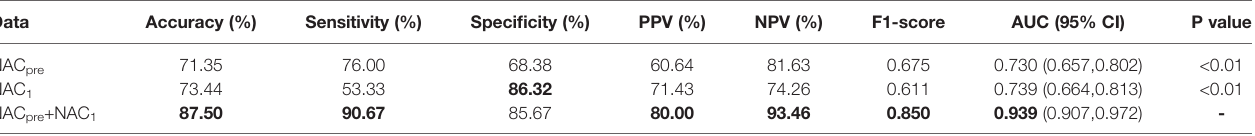
Values in bold black font represent the best performance in each column.